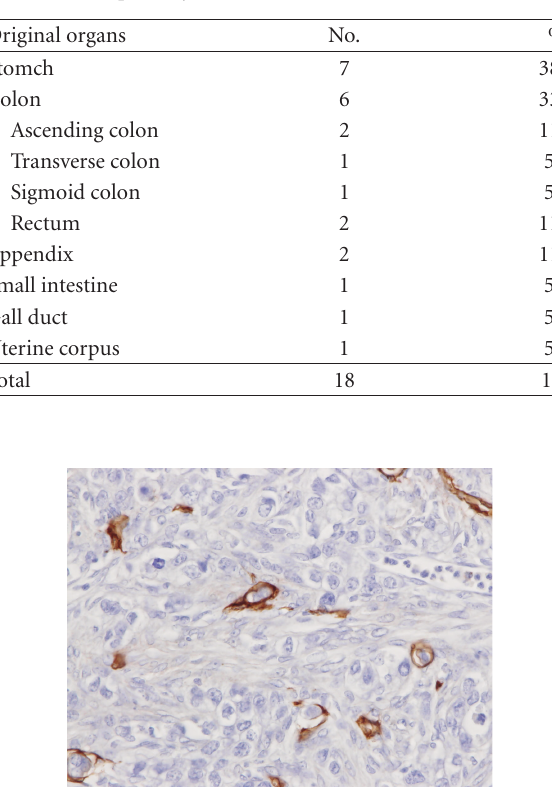
Table 1: The primary tumor sites of metastatic ovarian cancers.